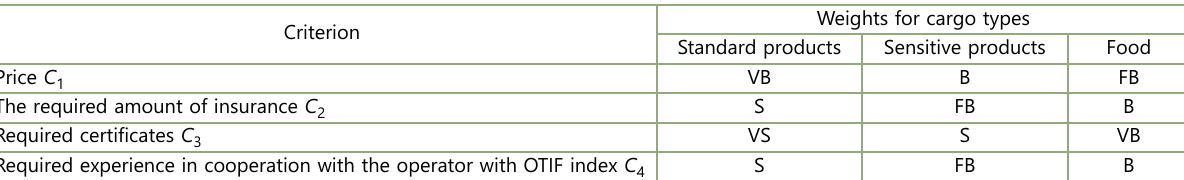
Table 9. Type of assessment parameters according to the individual product groups (source: own